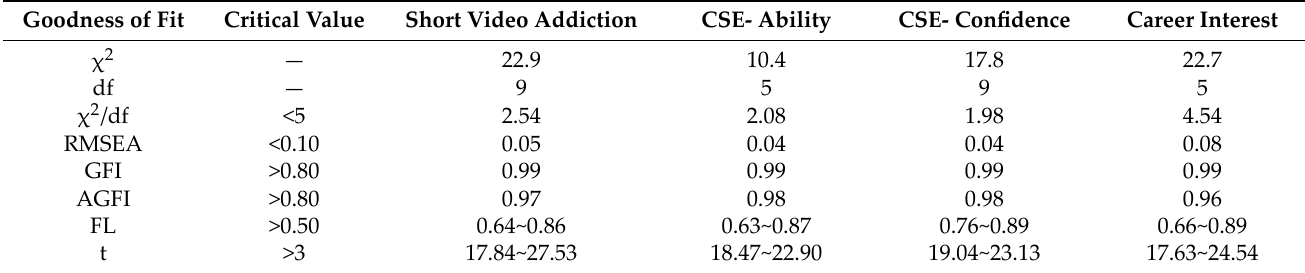
Table 1. Confirmatory factor